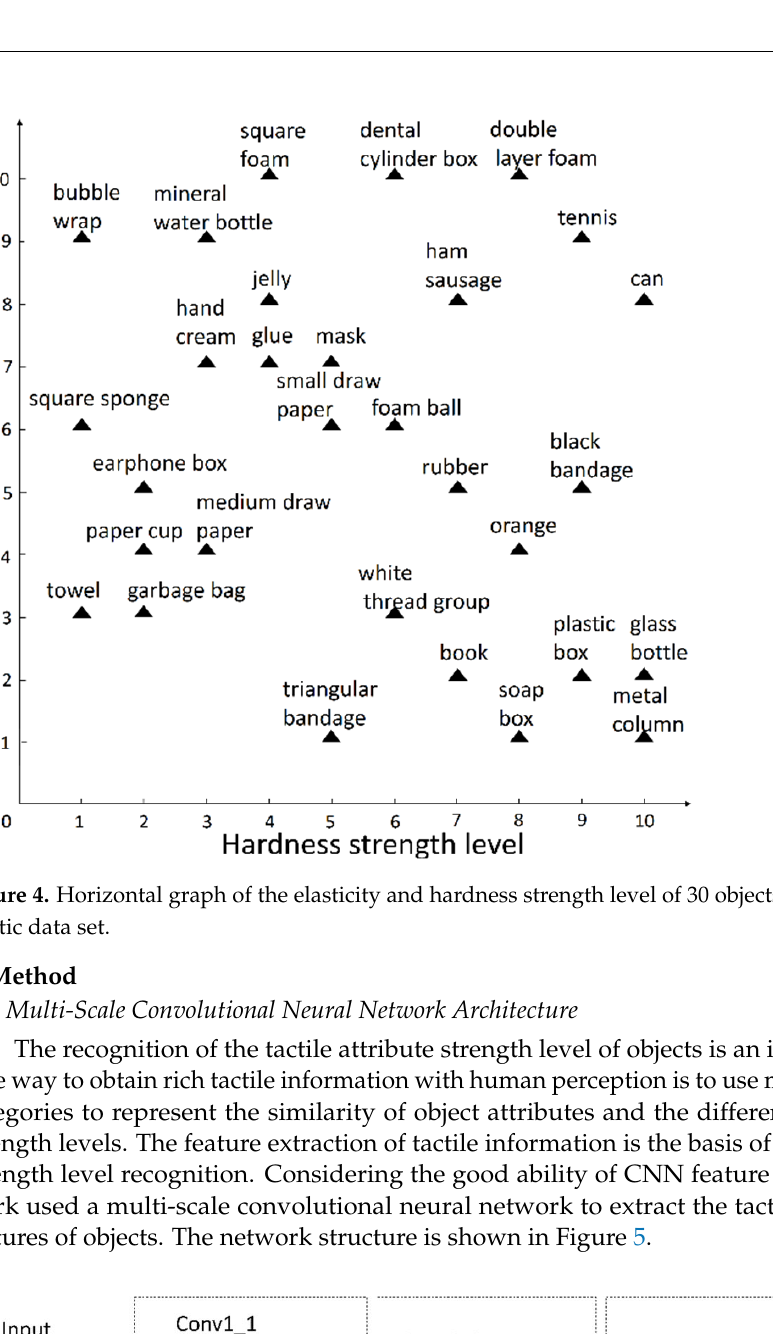
Figure 4. Horizontal graph of the elasticity and hardness strength level of 30 objects in the NumaTac haptic data set.